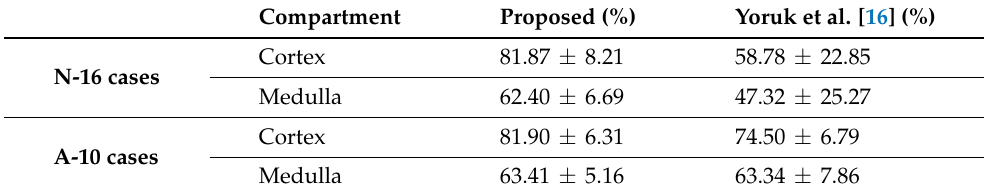
Figure 4. Box plots for two datasets depicting the medulla and cortex dice score coefficients (DSCs) for clinically “normal” and “abnormal” kidneys. Table 3. Mean medulla and cortex segmentation